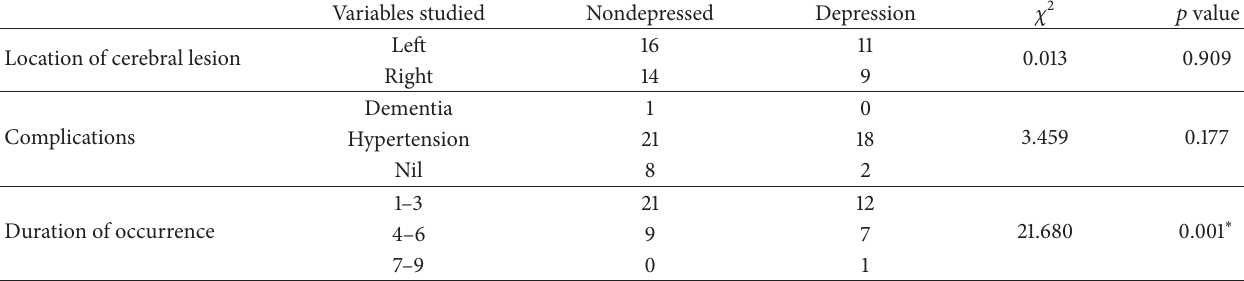
Table 3: Relationship between depression and clinical demographic variables (complications and presenting pattern; 𝑁 = 50